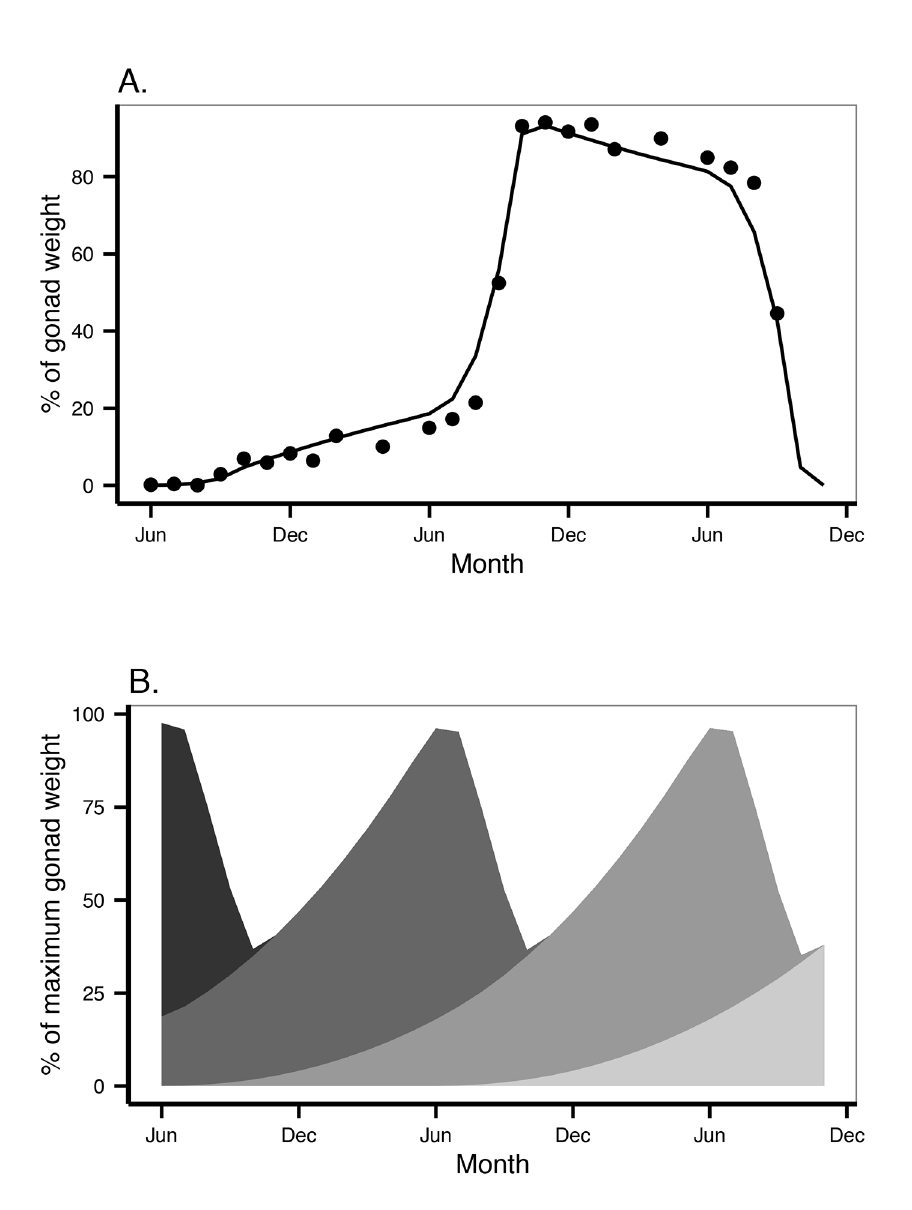
Fig 7. Gametogenesis. A. Proportional weight of one cohort of oocytes as it develop during two years and are released during reproduction. Dots were yielded from field observations made by Pearse [12]. The line is the DEB model output considering E R handling rules. B. Development of successive cohorts in time, each cohort grows following Eq